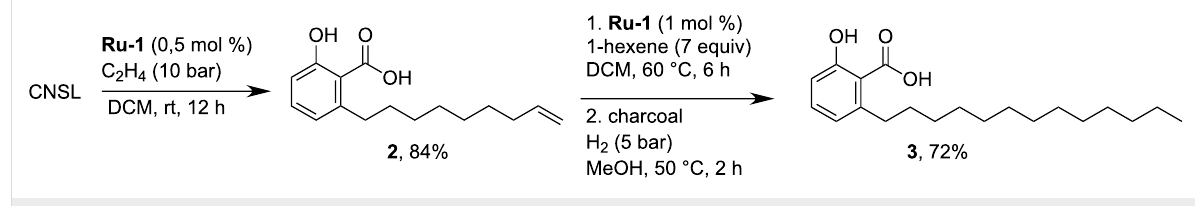
Scheme 4: Overall process in a preparative